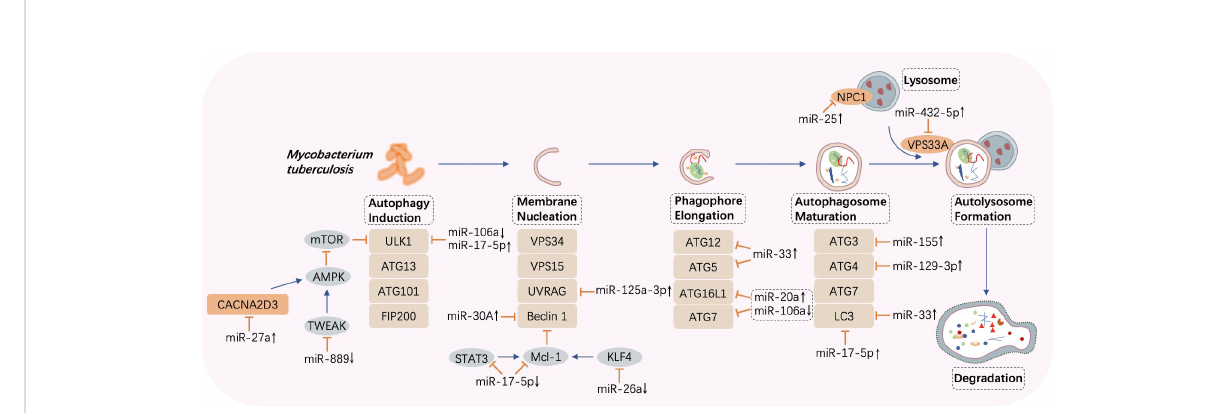
FIGURE 3 MicroRNA-regulated autophagy during Mycobacterium tuberculosis infection. Once autophagy is induced by Mycobacterium tuberculosis , several processes such as membrane nucleation to form the phagophore, elongation to realize autophagosome maturation, and the fusion between autophagosomes and lysosomes take place in turn. MicroRNAs (miRNAs) are differentially expressed and target crucial components in autophagy such as autophagy-related genes (ATGs), UV radiation resistance-associated gene (UVRAG), beclin 1, and microtubule ‐ associated protein 1 light chain 3 (LC3). CACNA2D3, calcium voltage-gated channel auxiliary subunit alpha2delta3; AMPK, adenosine 5 ’ monophosphate- activated protein kinase; TWEAK, tumor necrosis factor-like weak inducer of apoptosis; ULK1, Unc-51 like autophagy activating kinase 1; VPS, vacuolar protein sorting; STAT, signal transducer and activator of transcription; KLF, Krüpple-like factor. ↑ , upregulated; ↓ , downregulated; ⟶ , stimulate; ⟞ , inhibit.